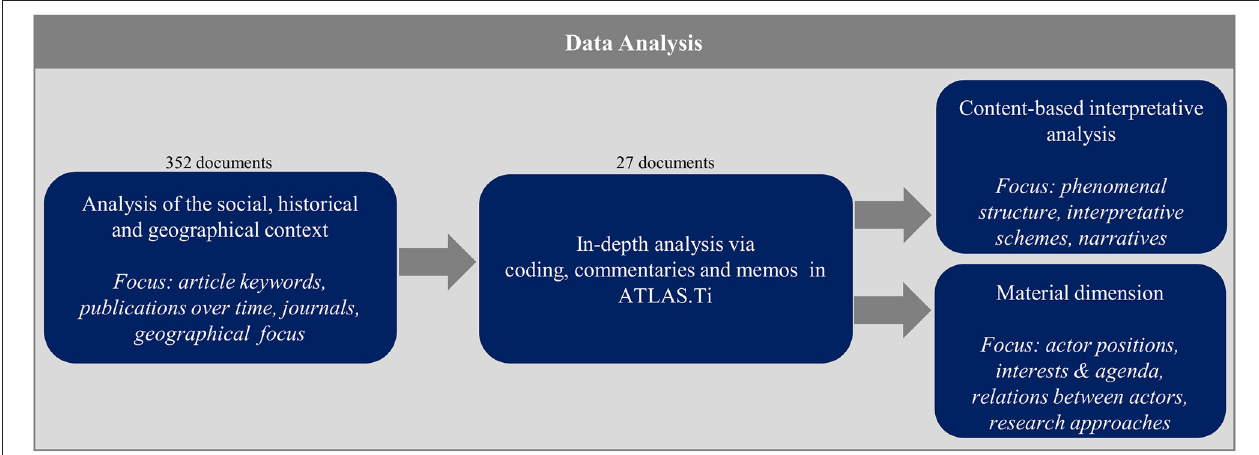
FIGURE 1 | Different steps of data analysis based on Keller